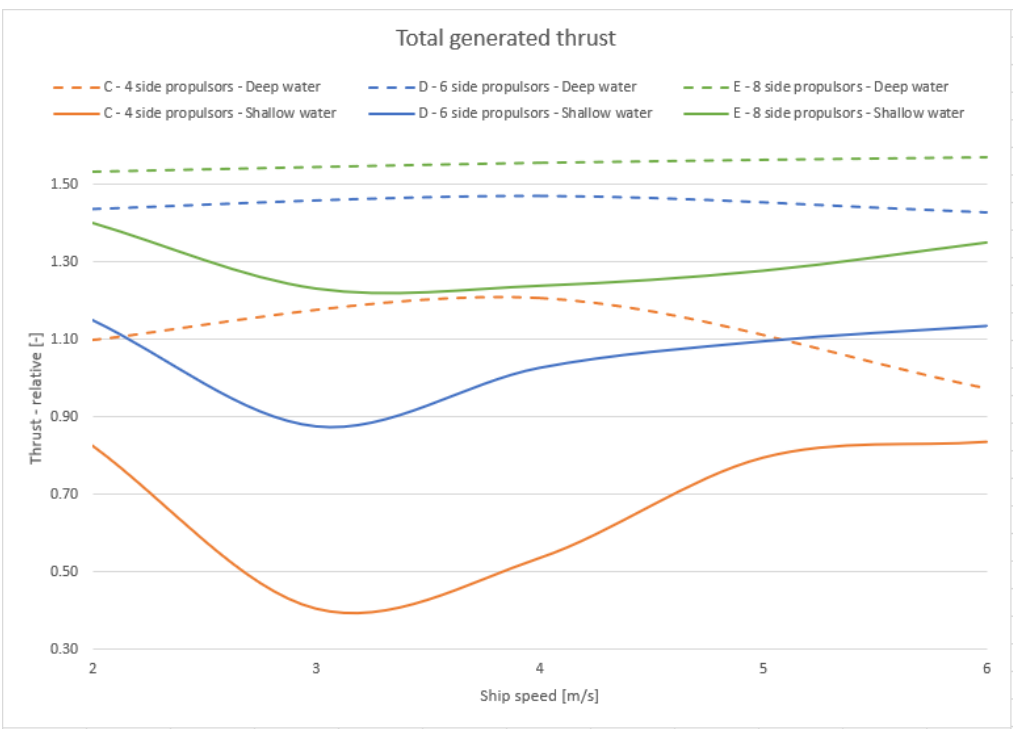
Figure 14. View of the aftship air intake zone (Layout A, shallow water). Source: Authors.